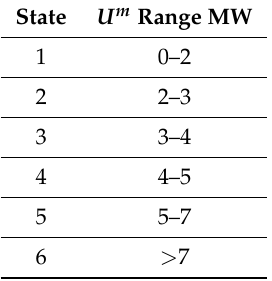
Table 3. U m index process